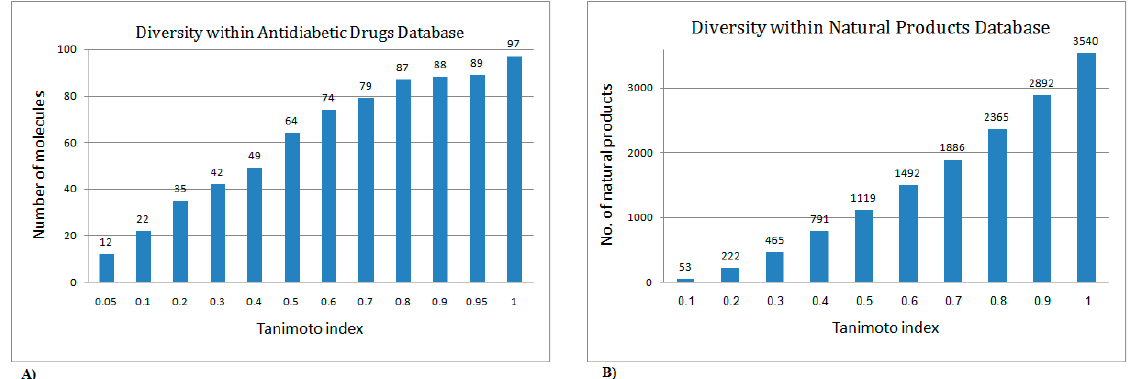
Figure 1. Diversity within anti-diabetic drugs ( A ) and diversity within the natural products database ( B